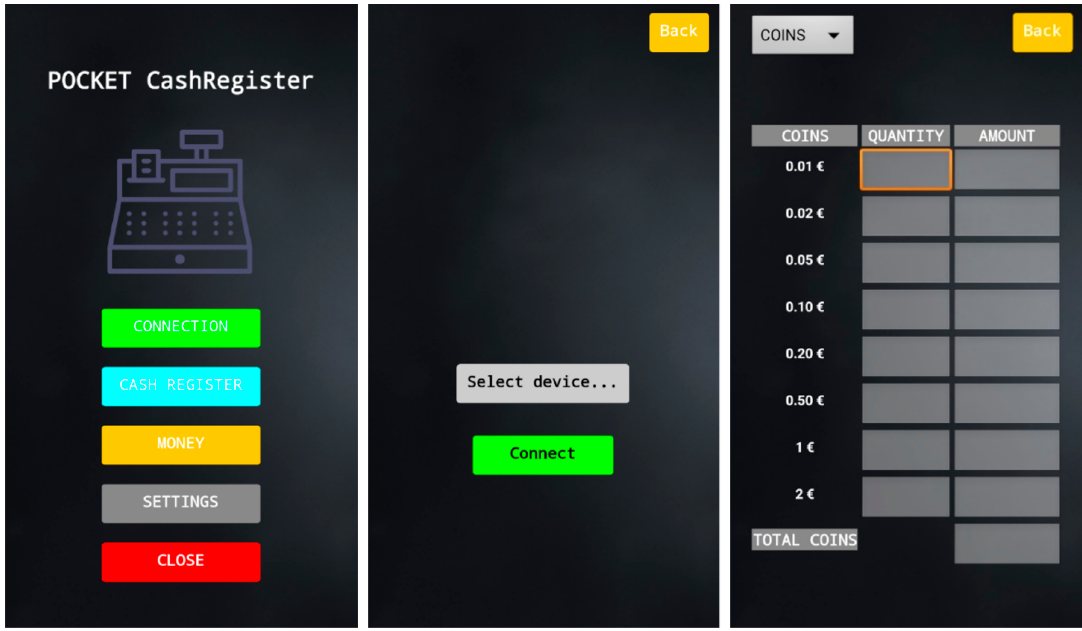
Figure 17. Screenshots of the Android application. From left to right, Main menu of the application, CONNECT screen, and MONEY screen.